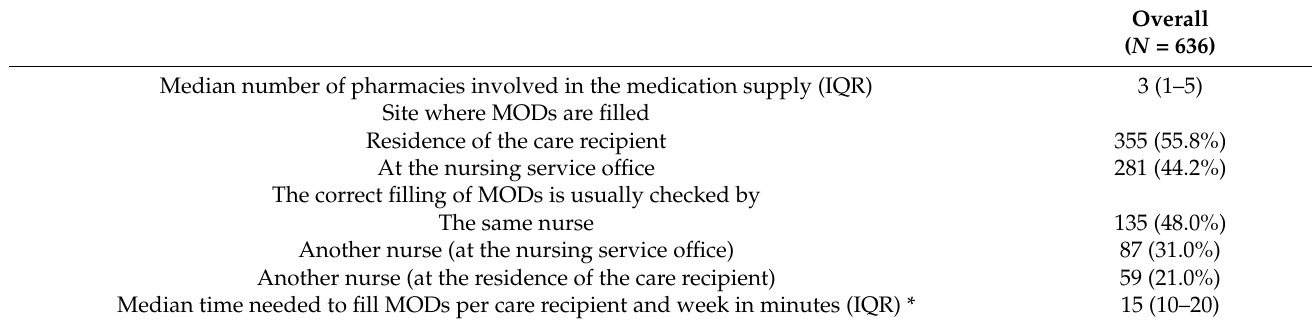
Table 2. Characteristics of home care nursing services filling